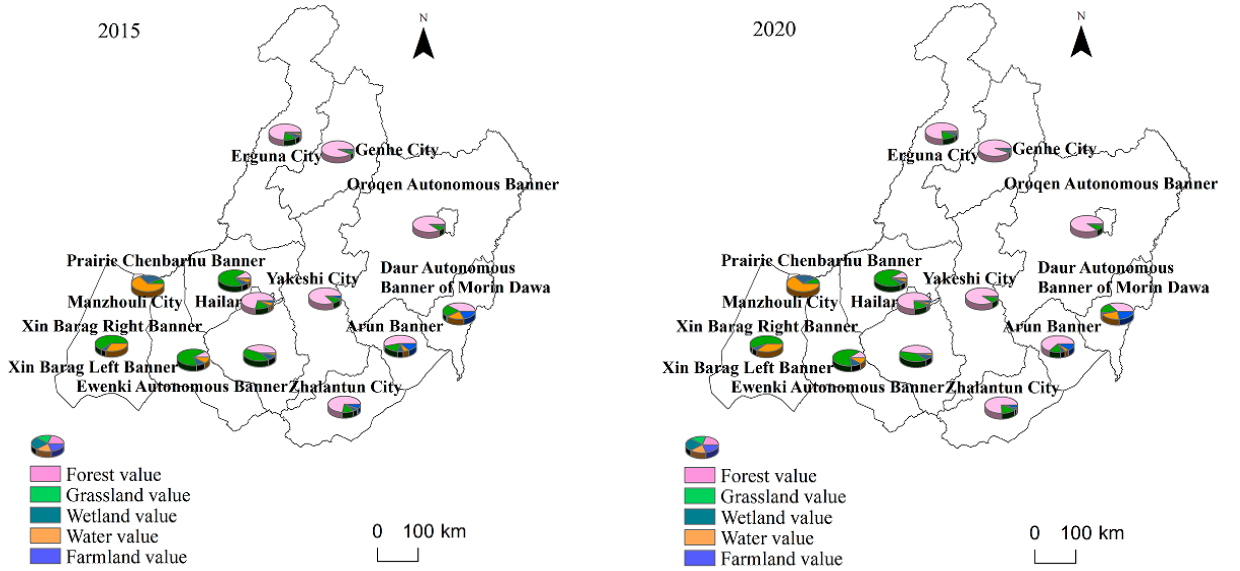
Figure 3. Proportion composition of ecological-type values of each region in 2015 and 2020.